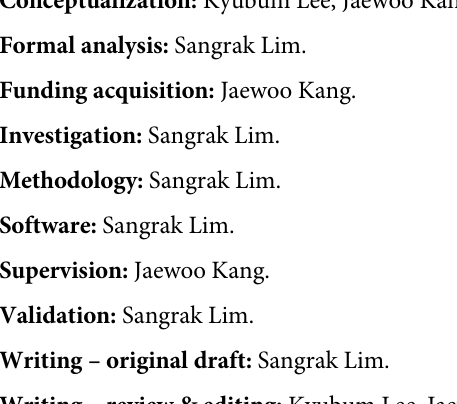
S1 Table. The number of instances in each of the four types of the DDIExtraction Chal- lenge’13 corpus after preprocessing. S2 Table. The F1-score comparison result of the individual classes. S3 Table. The comparison of the input features used in our method with those of other